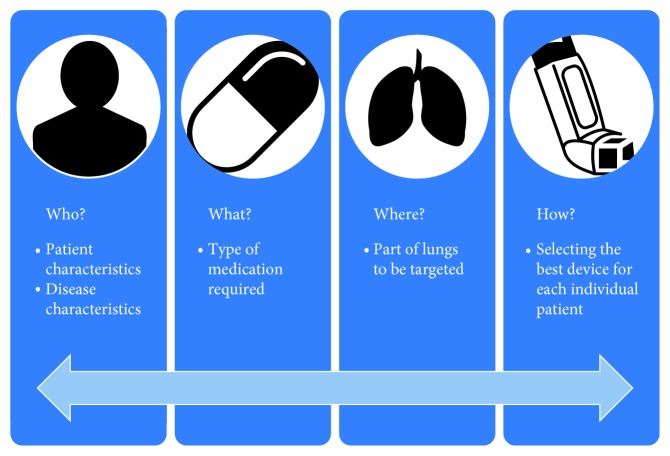
The 3W-H approach for prescribing inhalers [21].